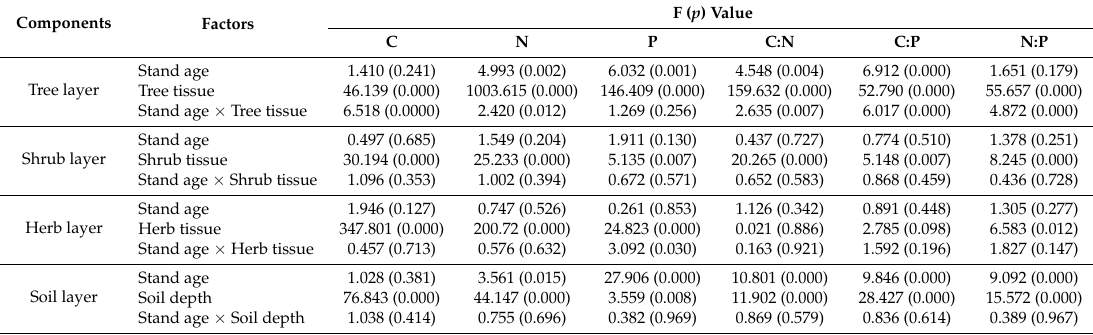
Table 2. F and p values for the effects of stand age, tree, shrub, herb tissue and soil depth on plant and soil C:N:P stoichiometric